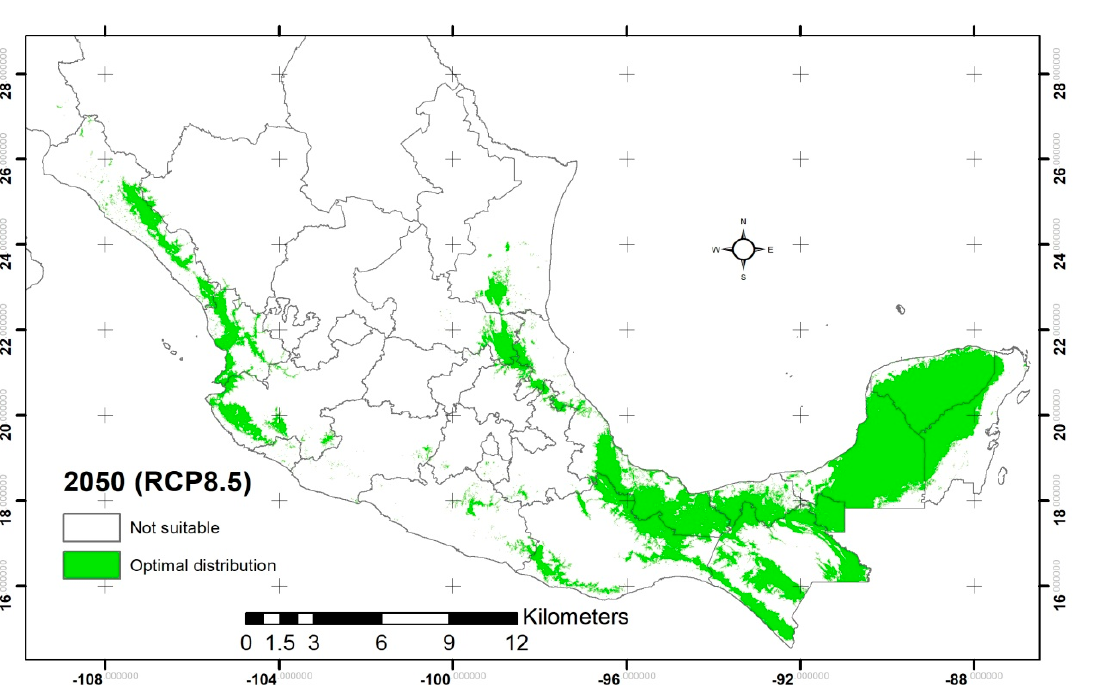
Figure 2. Potential distribution for the intermediate future (2050) of C. odorata in the NCAR model (CCSM4); for the conservative (RCP2.6) and drastic (RCP8.5) scenarios according to the optimum germination temperature range. Table 1. Surface with potential distribution of C. odorata according to climate change scenarios by state in the model